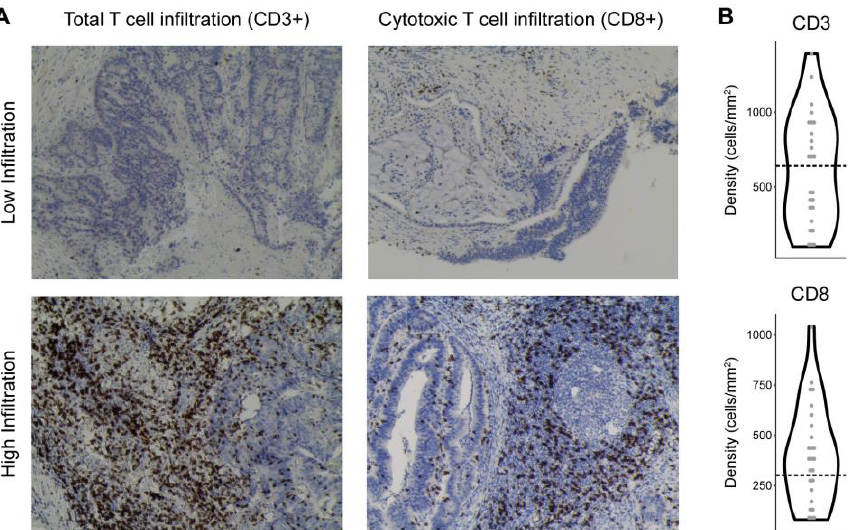
Figure 3. Patterns of T cell infiltration into colorectal tumor. ( A ) Representative immunohistochemistry images of CD3 (total T cells) and CD8 (cytotoxic T cells) staining in CRC samples with low or high T cell infiltration. ( B ) Violin plots showing the distribution of CD3 and CD8 density (cells/mm 2 tumor tissue) across CRC subjects. Thresholds distinguishing low vs. high T cell infiltration are indicated by dashed lines.